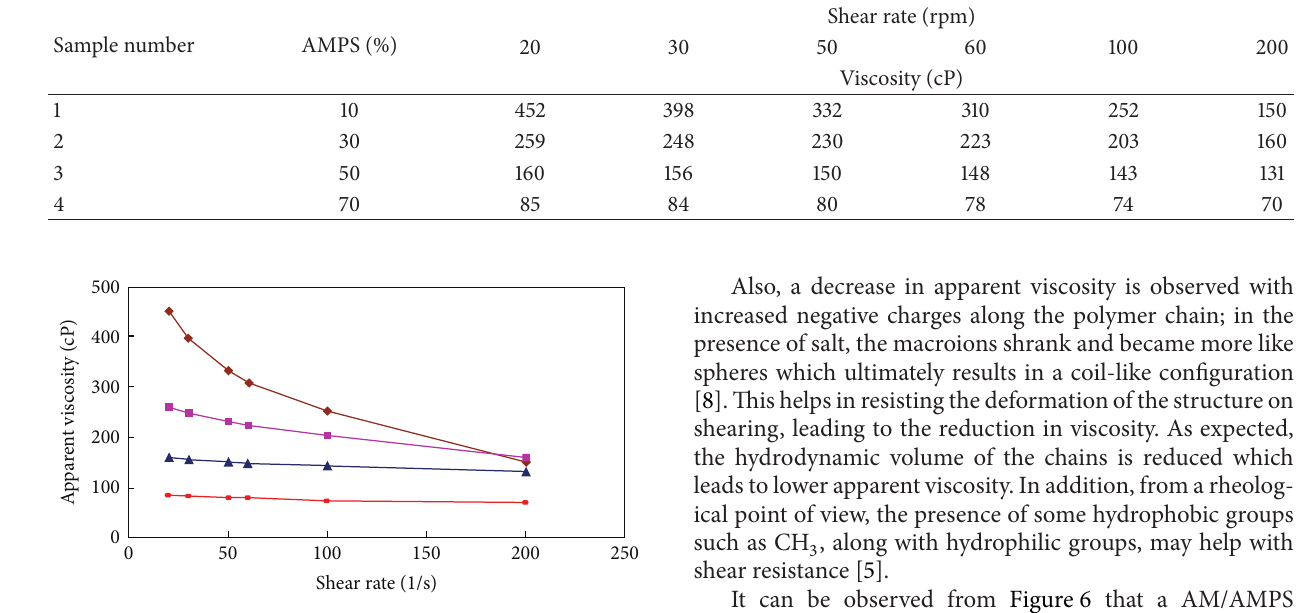
Table 2: Viscosities of samples at different ranges of shear rates.